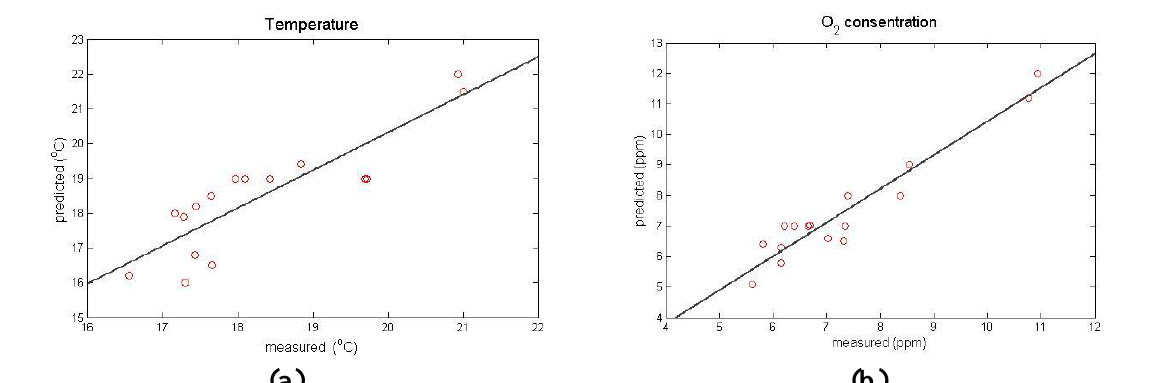
Figure 3. The correlation between measured (sensors network) and predicted (CFD model) values of the mean air temperature (a) and oxygen concentration (b)